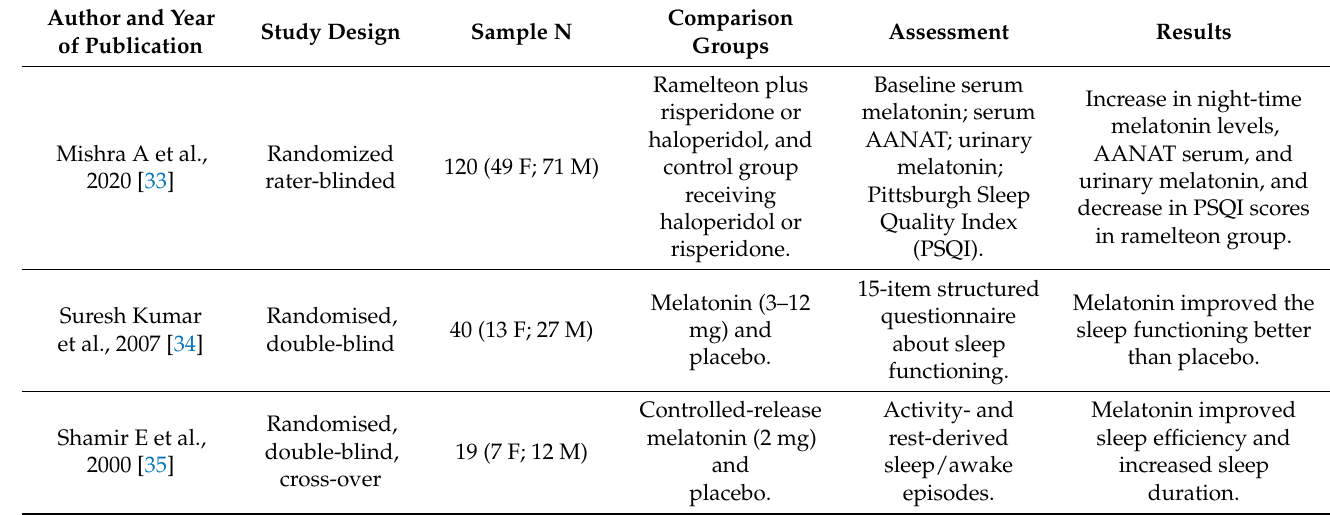
Table 1. Main characteristics of the most representative studies on the use of melatonin for